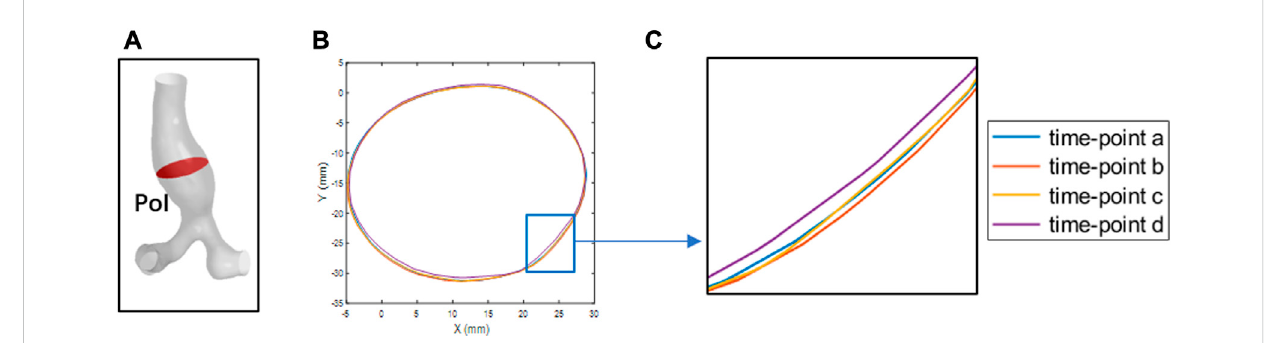
FIGURE 6 ThePOIatfour-timepointsisoutlined. (A) thePOIofabdominalaorticaneurysms. (B) theboundarycontoursatthefourspeci fi ctimepoints (C) local magni fi cation of (B)